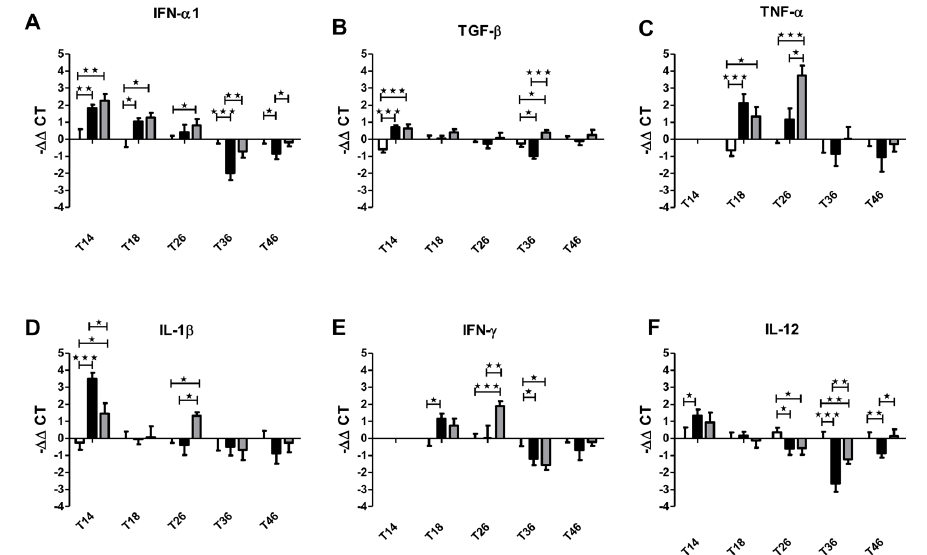
Figure 5. Kinetics of the effect of bacitracin/neomycin on the immune system of Atlantic salmon. The